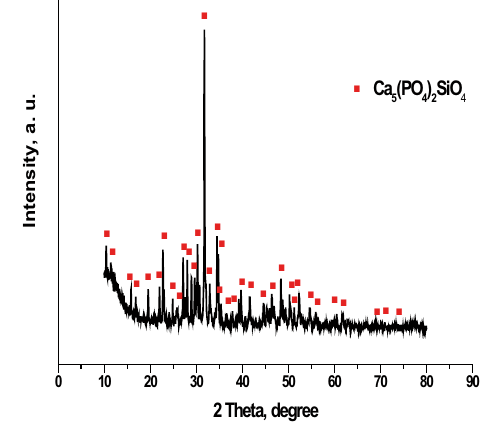
Figure 2. XRD of the prepared G/S hybrid (25:75 wt.%)